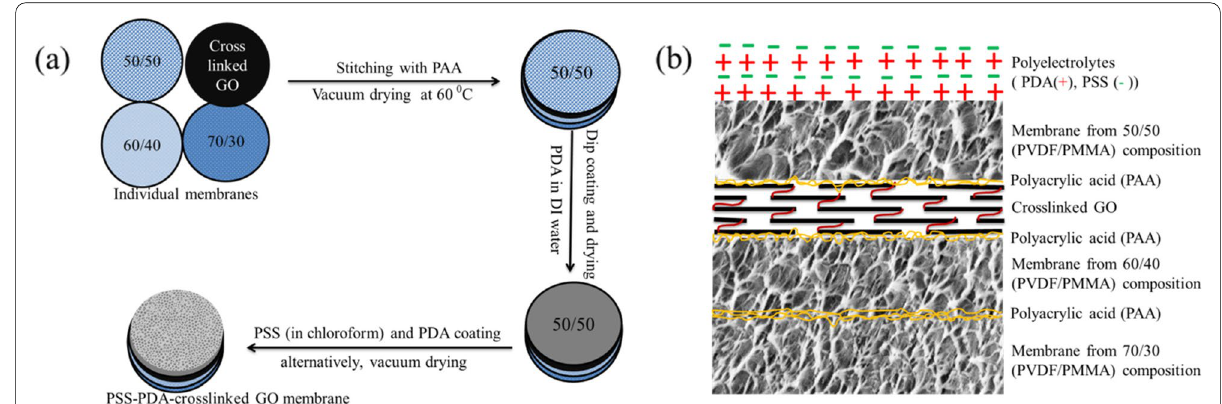
Fig. 3 A cartoon illustrating schematically ( a ) fabrication of PSS-PDA-crosslinked GO membrane ( b ) how different layers are stacked together in PSS-PDA-crosslinked GO